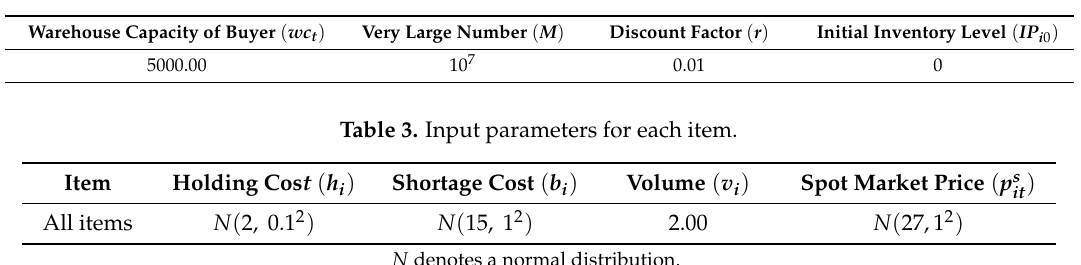
Table 2. Input parameters for the comparative experiment.